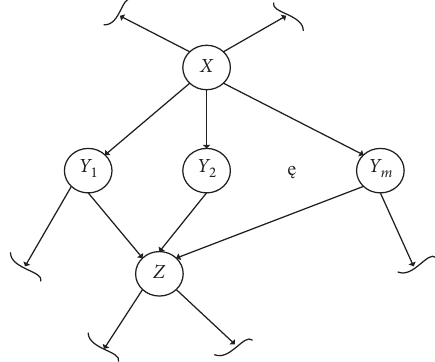
Figure 1: Schematic diagram of the impact